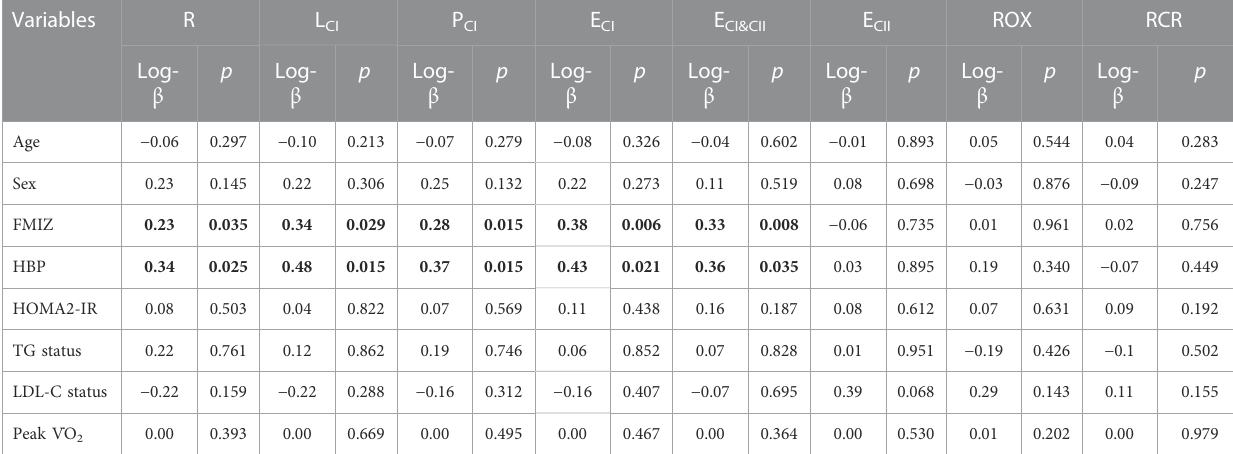
TABLE 4 Bivariate associations between measurements of platelet mitochondrial respiration, metabolic variables, and subject characteristics.